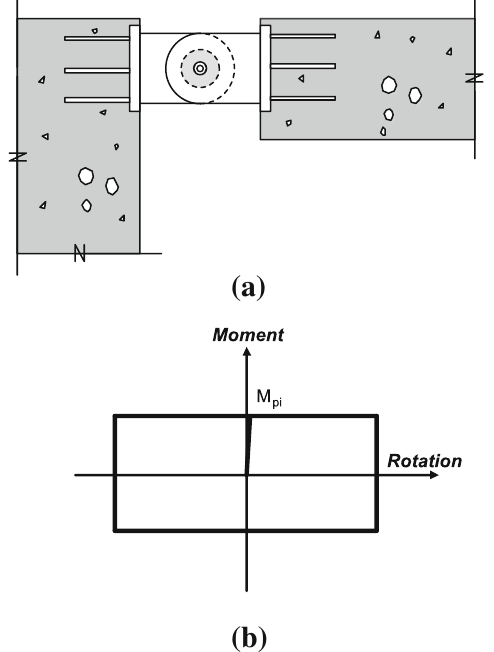
Fig. 18 Rotational friction damper considered in this study. a Installed configuration between staggered wall and connecting beam and b moment–rotation relationship.